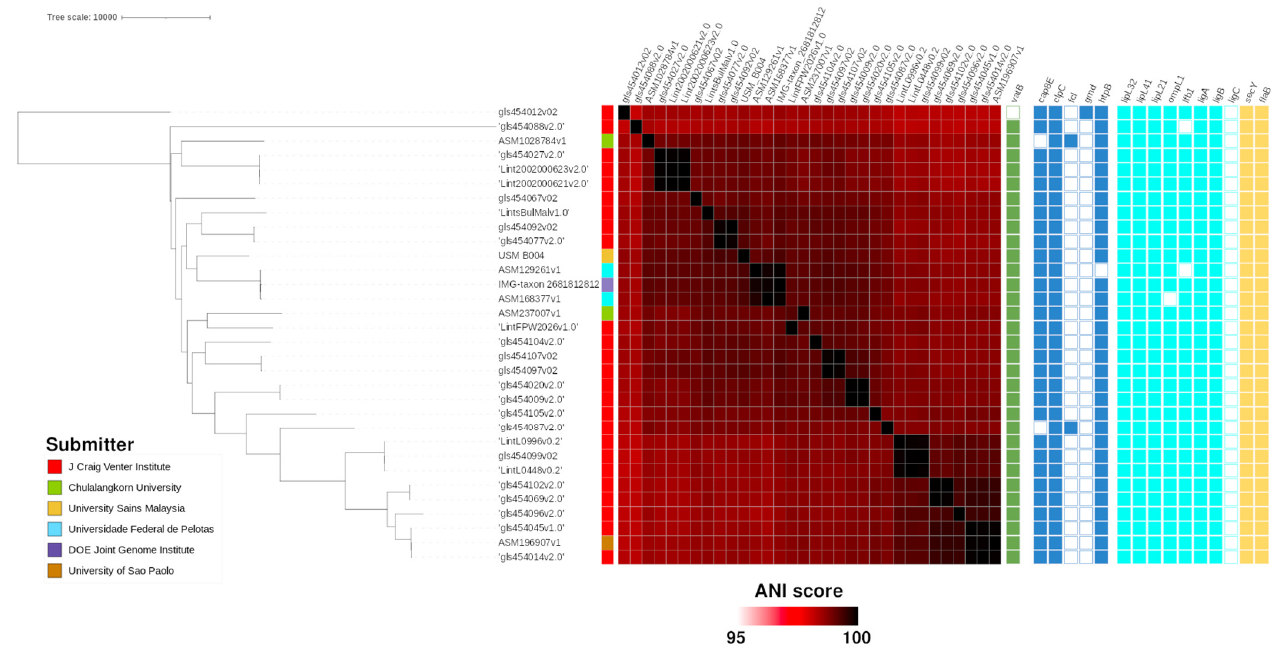
Figure 2. Phylogenomic tree of B004 genome against other L. interrogans genomes. Metadata information provided in order are genome submitter, pairwise ANI score, predicted antimicrobial resistance against the comprehensive antibiotic resistance database (CARD)and predicted virulence genes in VFDB, and predicted virulence genes